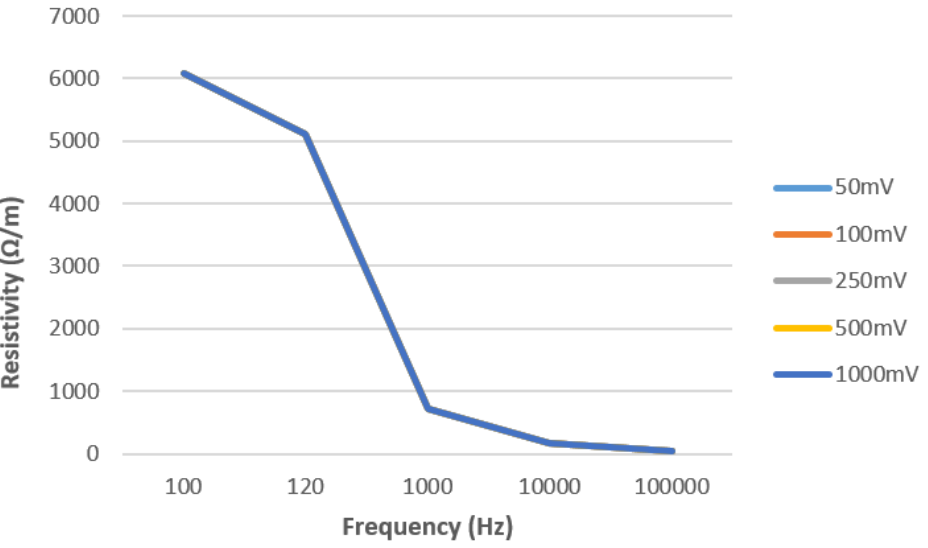
Figure 12. The resistivity of Cr ‐ ZnSe crystal as the function of frequency at different bias voltages. Bias did not change resistivity.